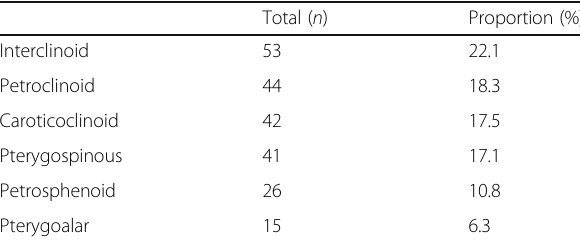
Table 2 Ossification of ligament types (in descending order of frequency)